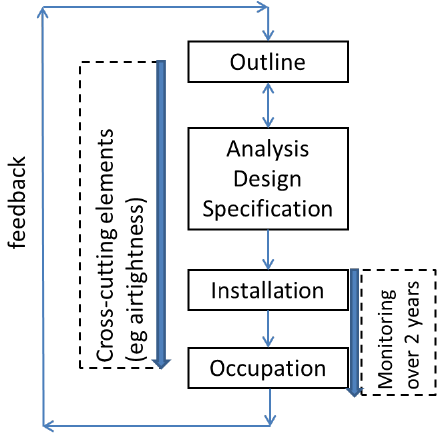
Figure 2. Management model for design—construction—operation proposed by the bureau d’étude thermique interviewed